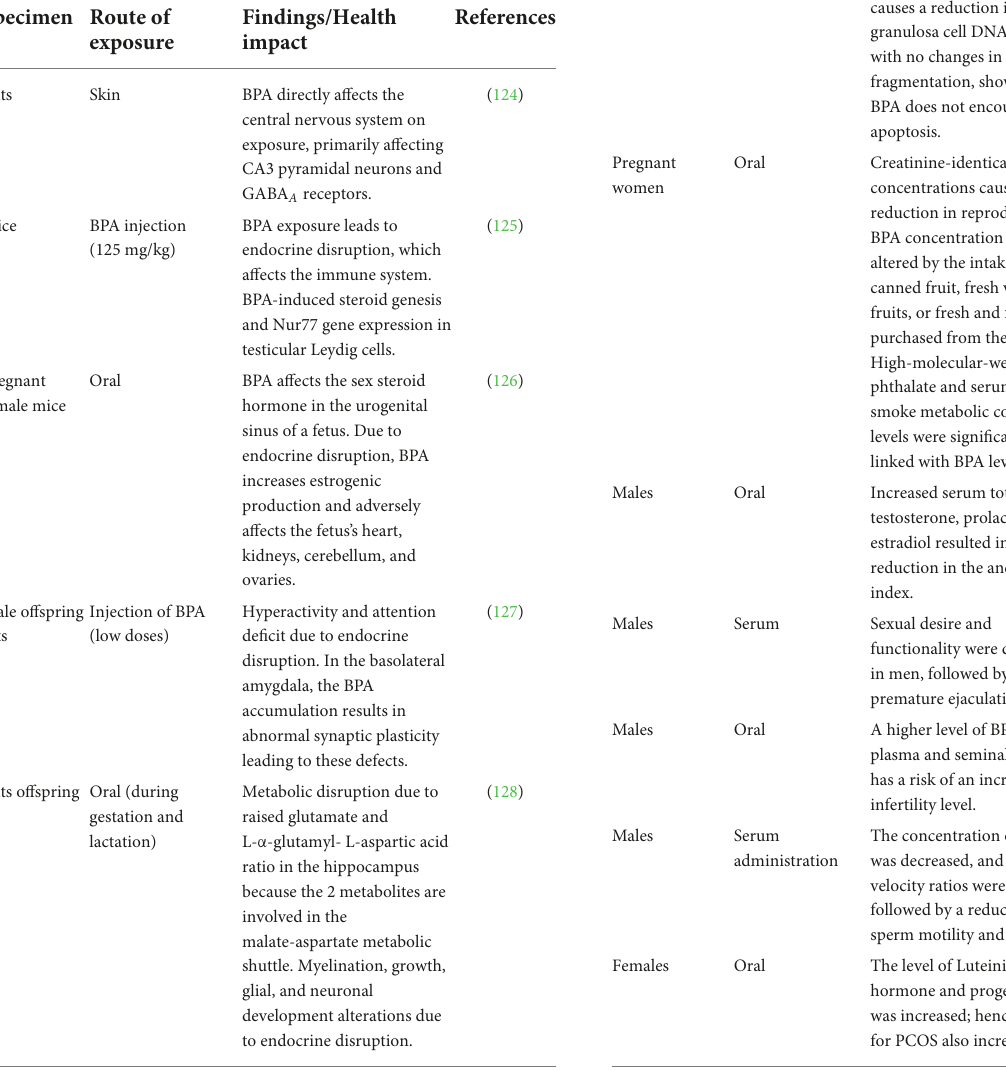
TABLE 2 Effect of BPA on the endocrine system.